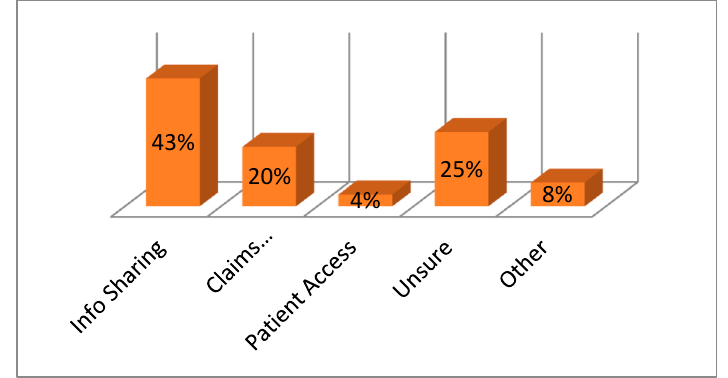
Figure 3. Blockchain awareness among e-healthcare persons [4,5].